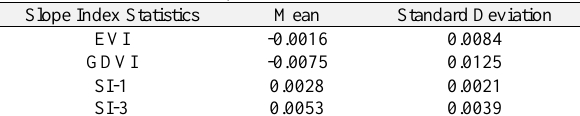
2. Table 2. Mean and Standard deviation of generated slope maps from optimal indicators Slope Index